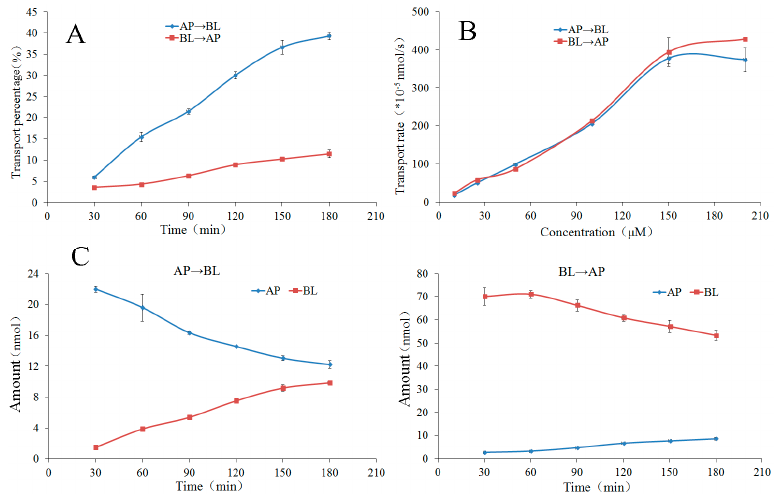
Figure 6. The transport percentage as a function of time at 50 µM ( A ), transport rate as a function of concentration at 90 min ( B ) and transport kinetics curves ( C ) of the flavonone 9 in Caco-2 monolayer. Data are the mean ± S.D ( n = 3).